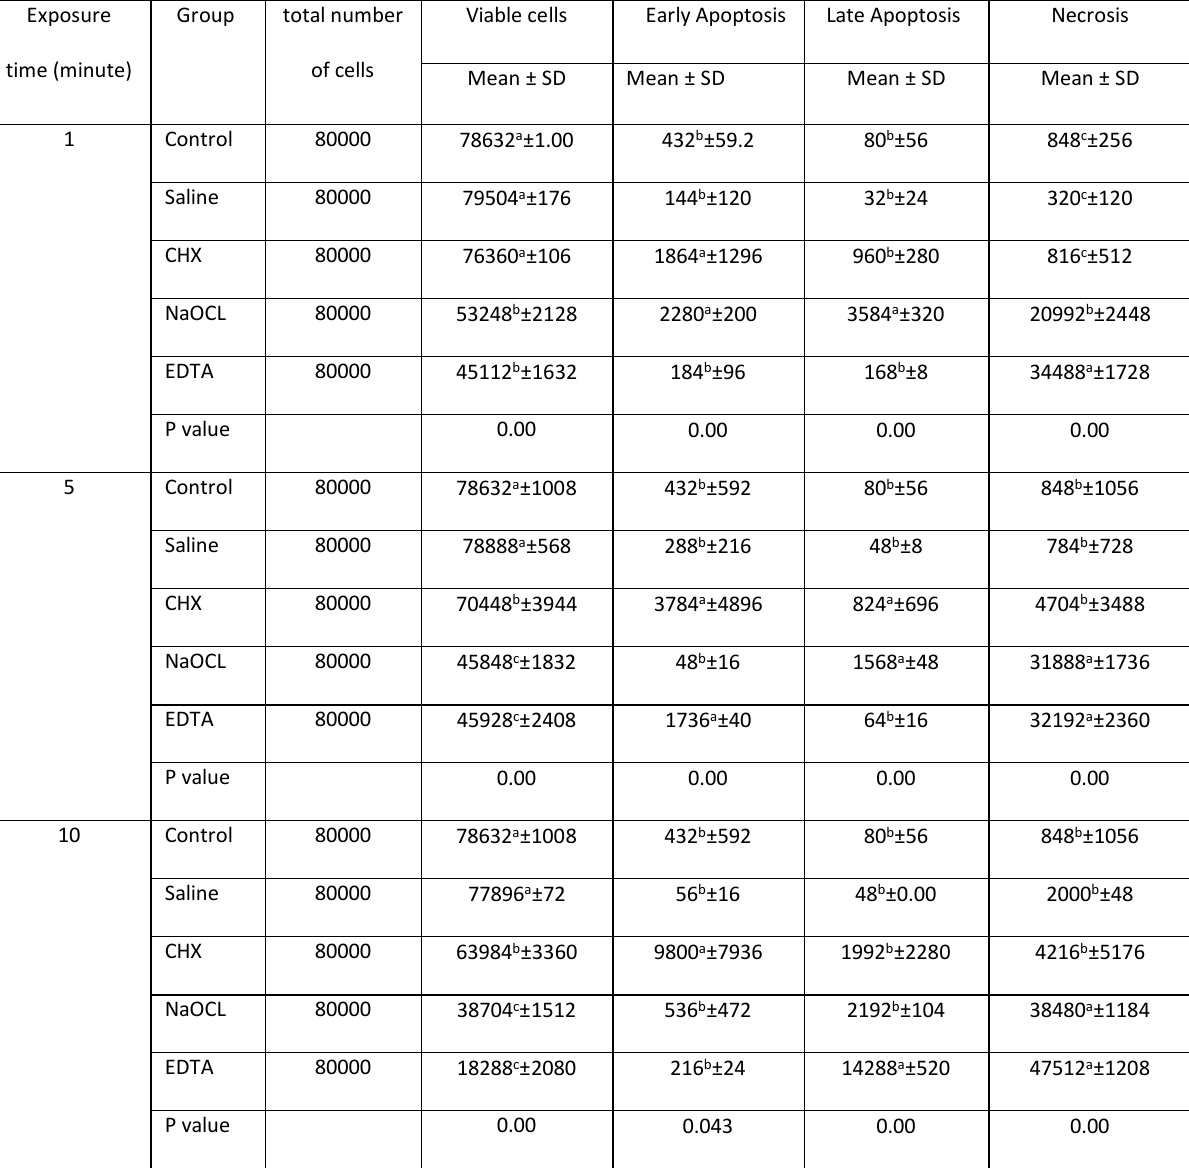
Table 2. Cell viability,early apoptosis, late apoptosis and necrosis in co-cultured PDLSCs at different times of treatment with endodontic irrigating solutions.